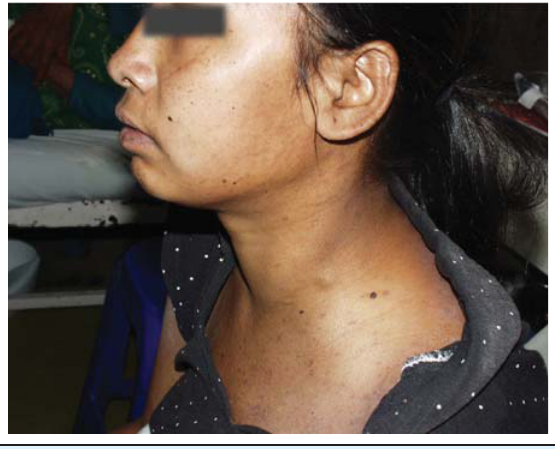
Figure 1. Cord-like swelling over the left side of the neck; the left side of face also looks puffy.